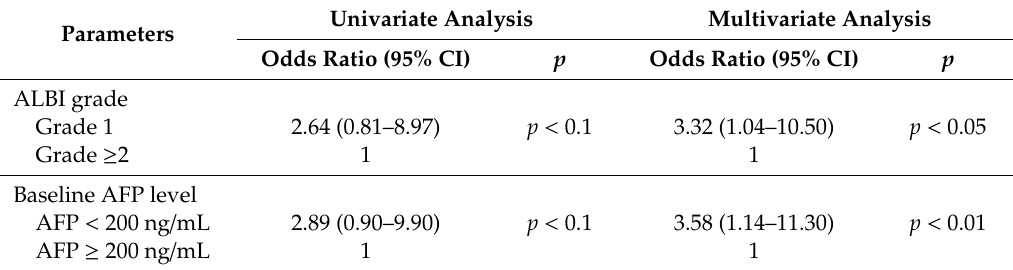
Table 4. Univariate and multivariate logistic regression analysis for factors a ff ecting ORR.